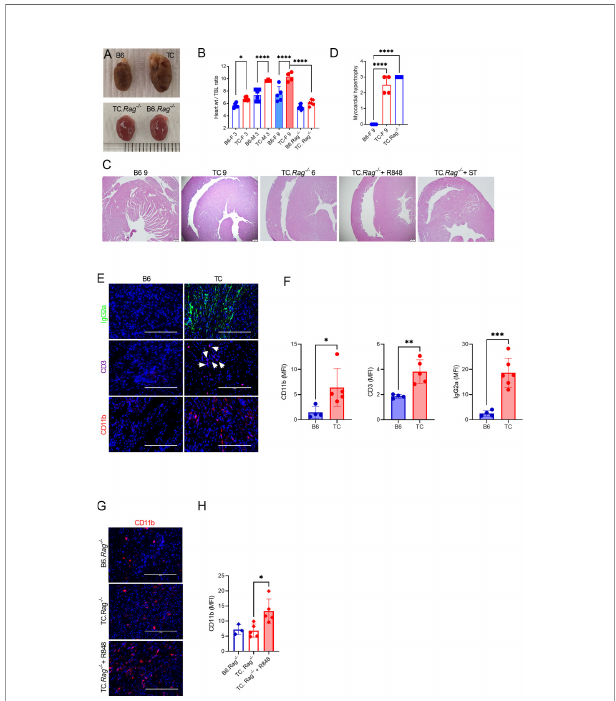
FIGURE 7 | Both lymphoid and myeloid cells contribute to TC cardiovascular phenotypes. (A) Representative hearts from 9-months old B6 and TC mice and 6-months old B6. Rag -/- and TC. Rag -/- mice photographed at the same ampli fi cation. (B) Heart to tibia length ratios. (C) Representative H&E-stained heart sections (4X, scale bars: 200 um) of the indicative strain/conditions. (D) Myocardial hypertrophy scores. (E) Representative heart sections from 9 months old B6 and TC mice stained for IgG2a, CD11b and CD3 (20X, scale bars: 200 um). (F) Quanti fi cation of CD11b + and CD3 + cells and IgG2a deposits (MFI). (G) Representative heart sections of 6-months old B6. Rag -/- and TC. Rag -/- mice, treated or not with R848, stained for CD11b (20X, scale bars: 200 um). (H) Quanti fi cation of CD11b + cells (MFI). n = 3 - 10 mice per group, 1-way ANOVA, with multiple comparison tests, *: P < 0.05, **: P < 0.01, ***: P < 0.001. ****: P <